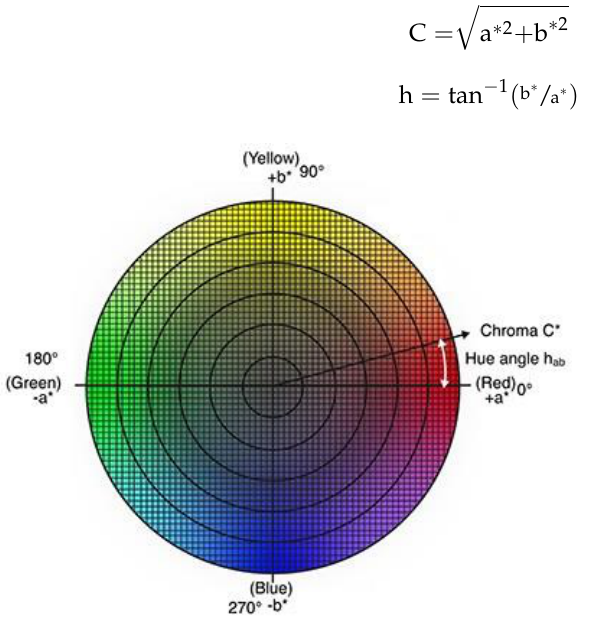
Figure 2. Graphical interpretation of chroma and hue in the color sphere for a* and b* coordinates section. Image from https://sensing.konicaminolta.us/us/blog/understanding-the-cie-lch-color-space/ (accessed on 4 April